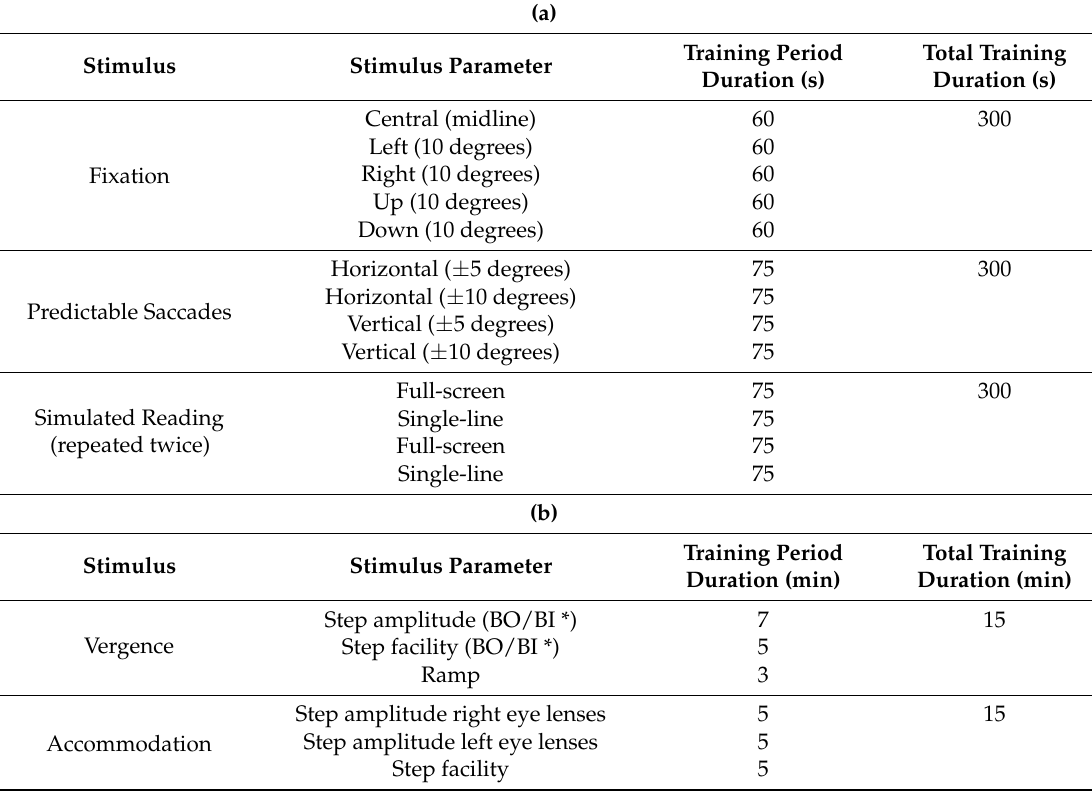
Table 1. ( a ): Stimuli for version training protocol [26]; ( b ): Training protocol for vergence and accommodation